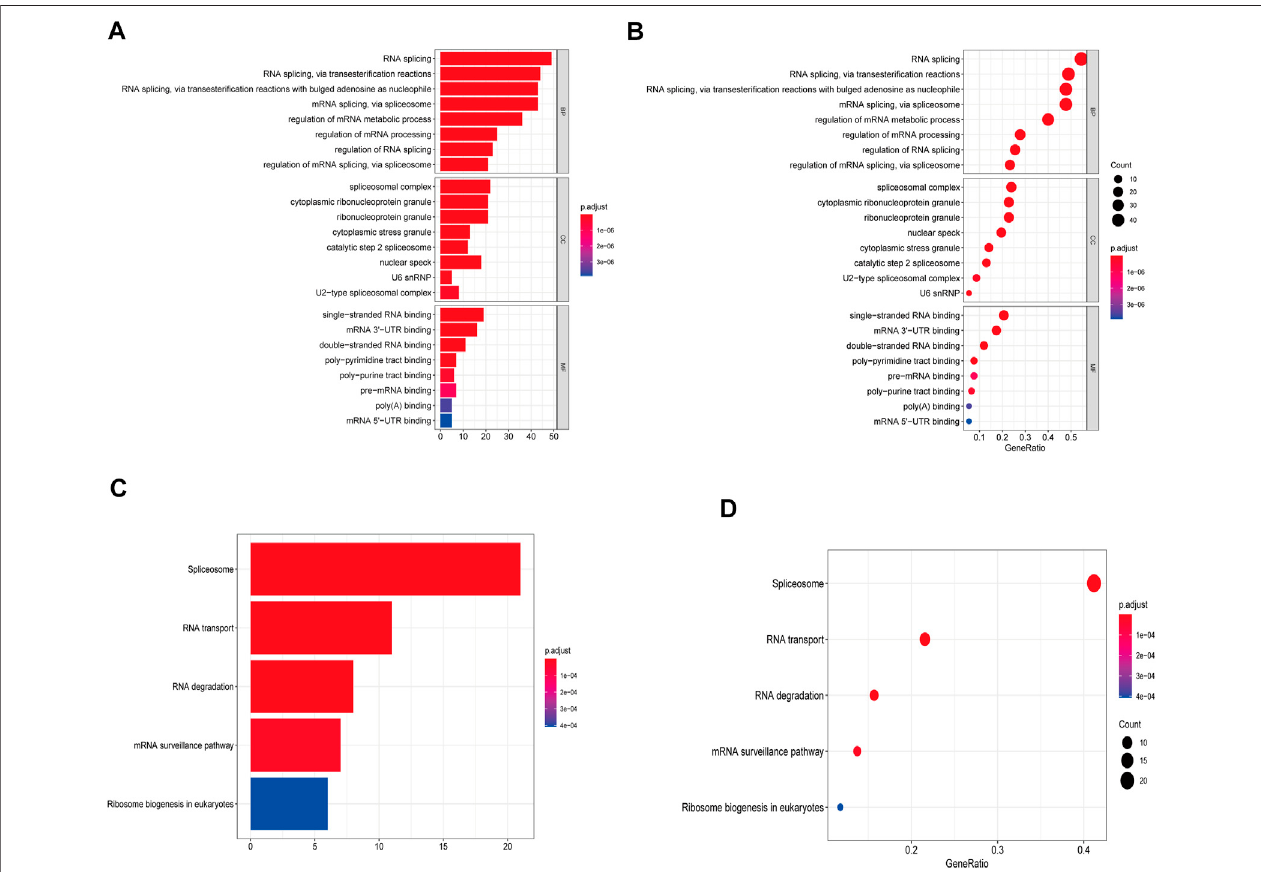
FIGURE8| GOandKEGGanalysis. (A,B) ThebarplotanddotplotofGOanalysisforthetopeightenrichment. (C,D) ThebarplotanddotplotofKEGGanalysisfor the top fi ve enrichment.